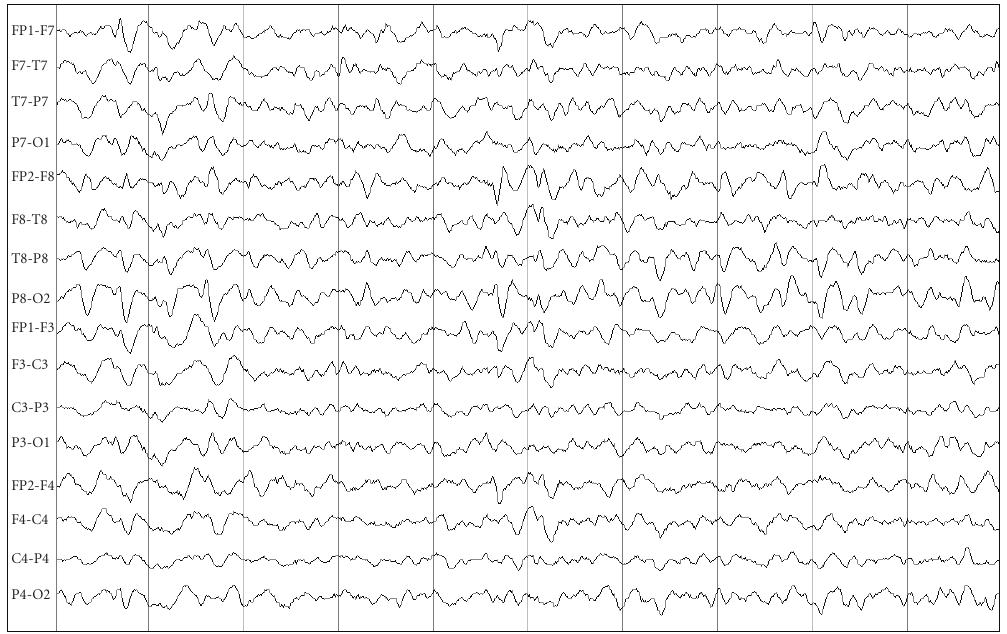
Figure 1: EEG before valproate therapy showing bilateral sharp wave discharges.